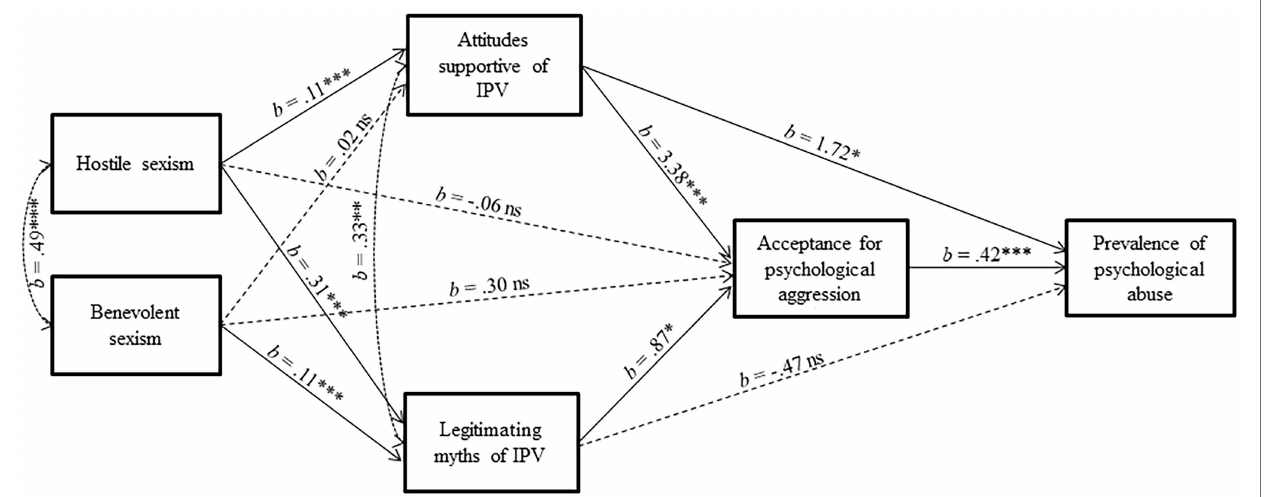
N = 408. For each category of the Acceptance for psychological aggression scenarios, the table shows the proportion (%) of participants regard to acceptability/unacceptability of the behaviors